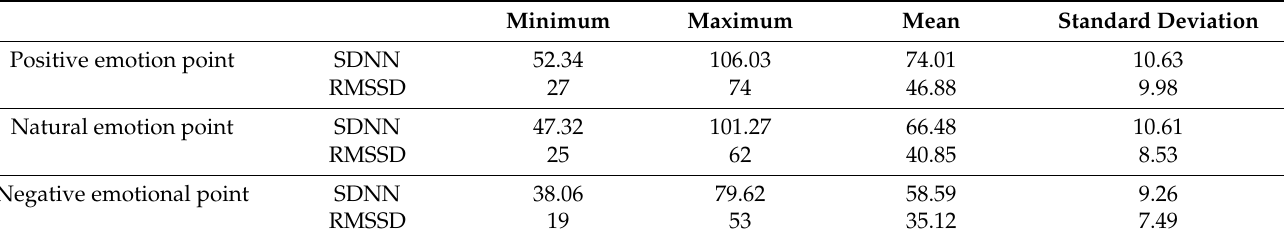
Table 1. Descriptive statistics of physiological data.